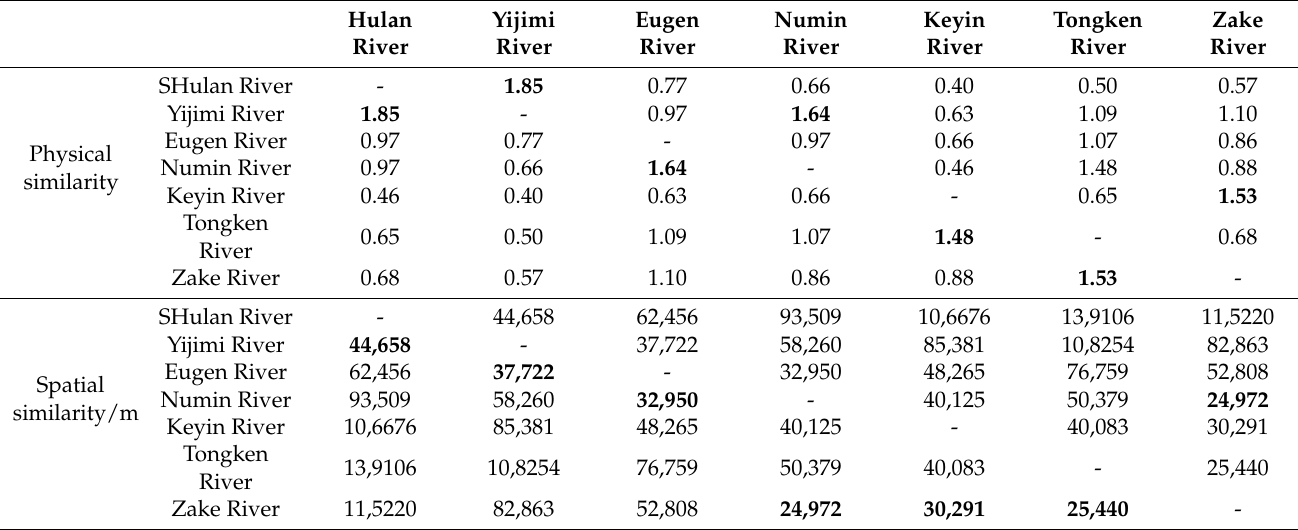
Table 4. Physical similarity and spatial similarity of the Hulan River Basin based on leave-one-out cross validation (the bold value indicated the best reference